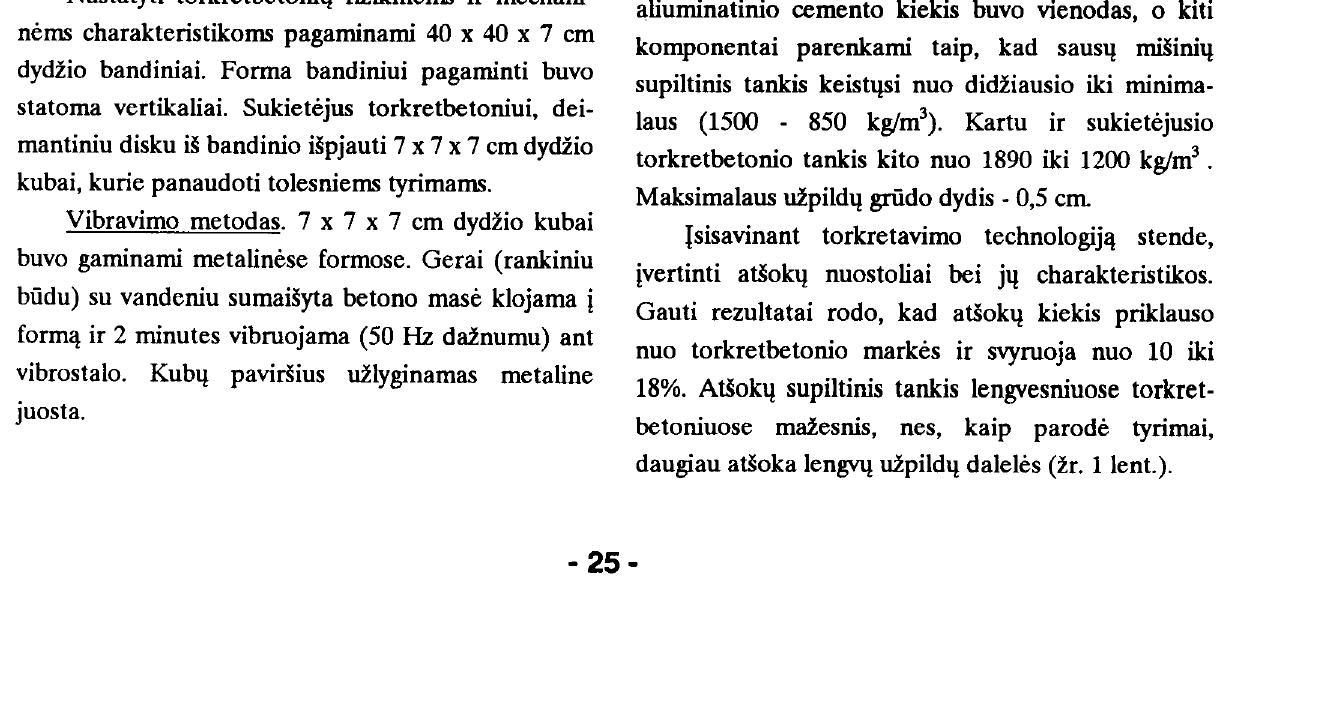
Fig. 1. Scheme of gunning machine: 1 - hopper; 2 - mixer; 3 - air duct; 4 - rotor; 5 - hatcher ducts Eksperimento metu buvo palaikomas 1,8 - 2,0